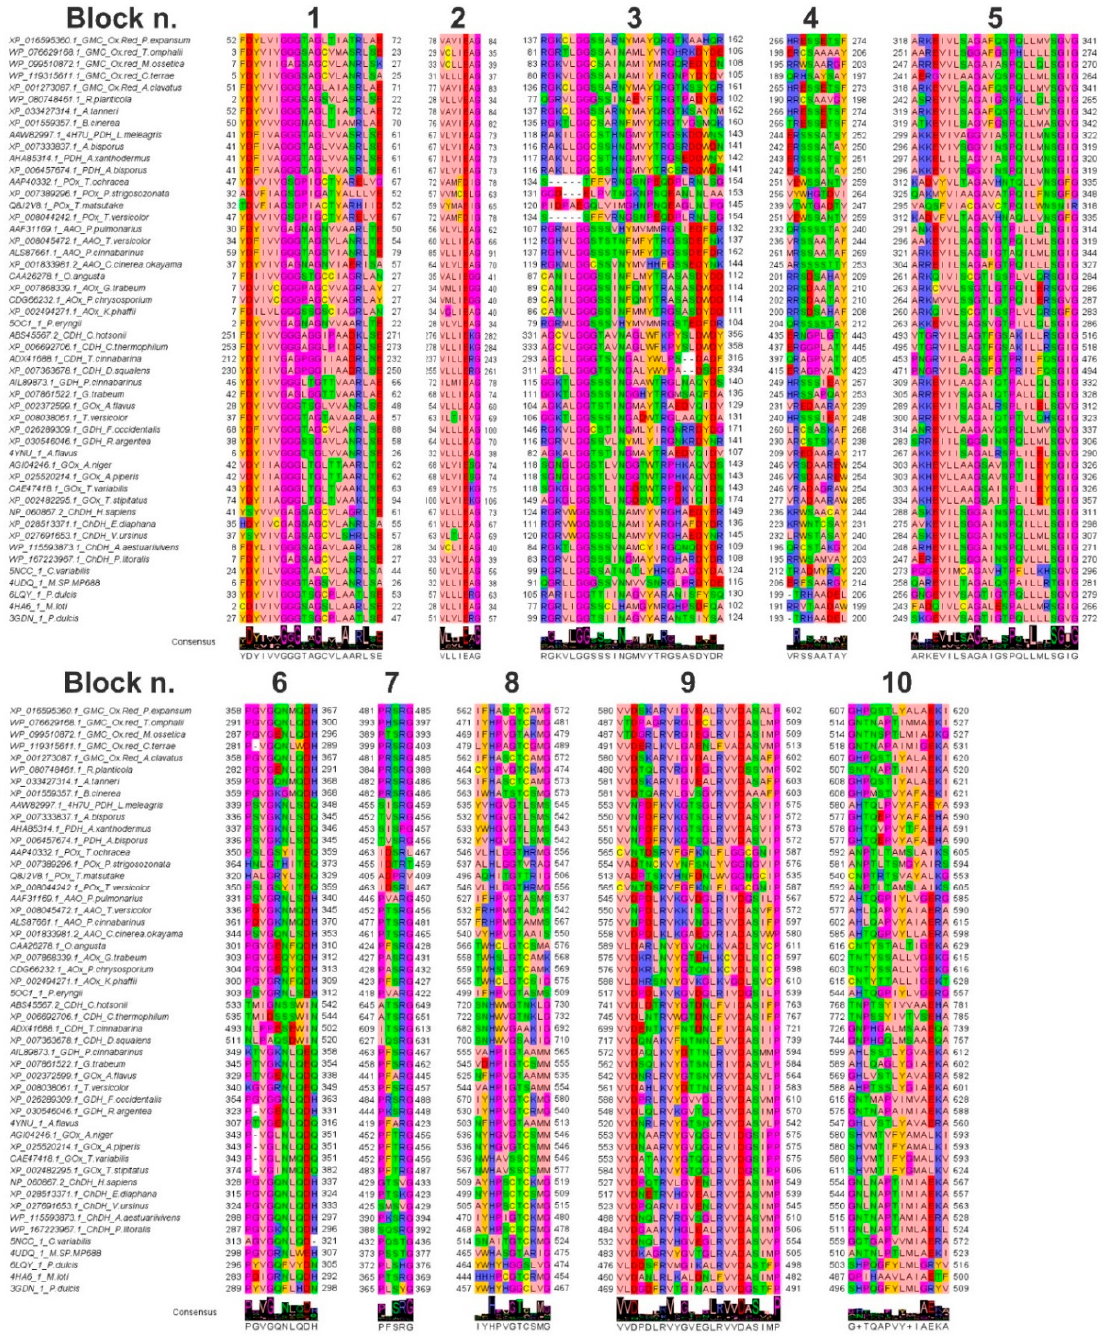
Figure 2. GMC oxidoreductase conserved amino acid blocks. Blocks of conserved amino acids detected by comparing the GMC oxidoreductases sampled through blastp searches and aligned by ClustalW. The highlighted amino acid blocks are numbered (1–10, following their description reported in Section 3.2) and revealed crucial protein regions involved in the FAD binding and/or in the binding of the substrate or more in general residues important for the protein function mechanism. The jalview Zappo color style was used for coloring amino acids. Logo representation is also reported to highlight the most conserved